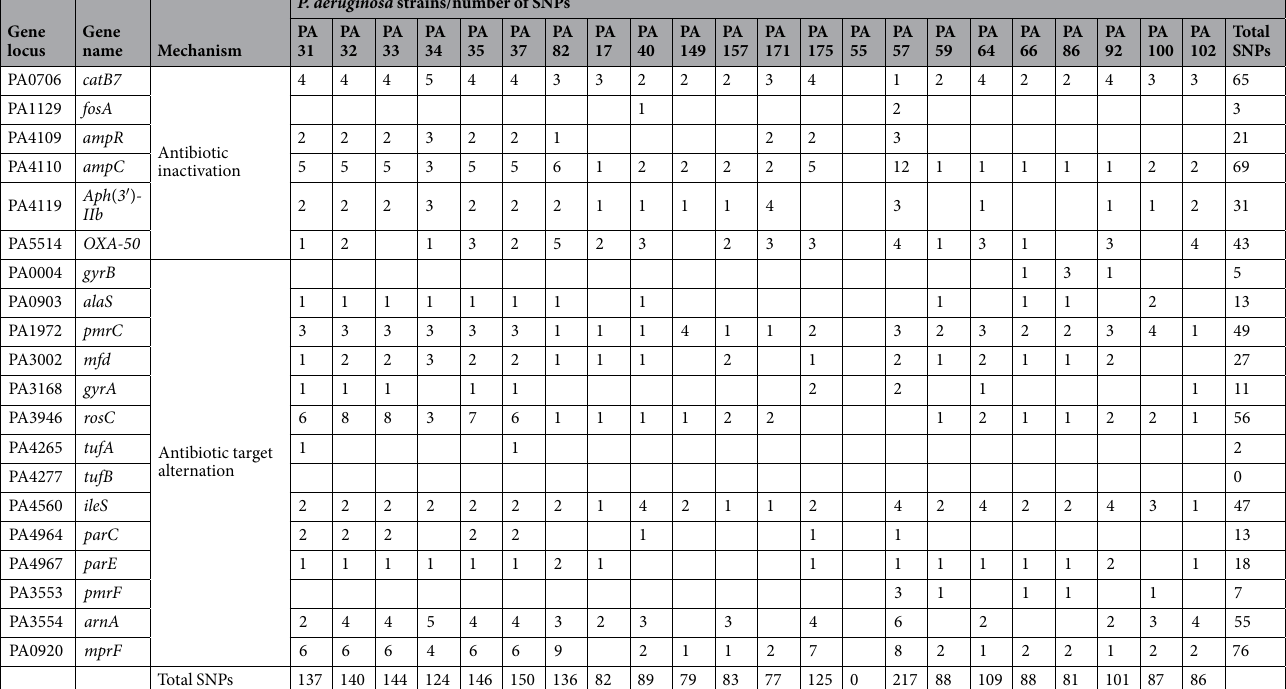
Table 3. Non-synonymous SNPs detected in the 73 genes related to antibiotic resistance in the 22 isolates studied using PAO1 as the reference